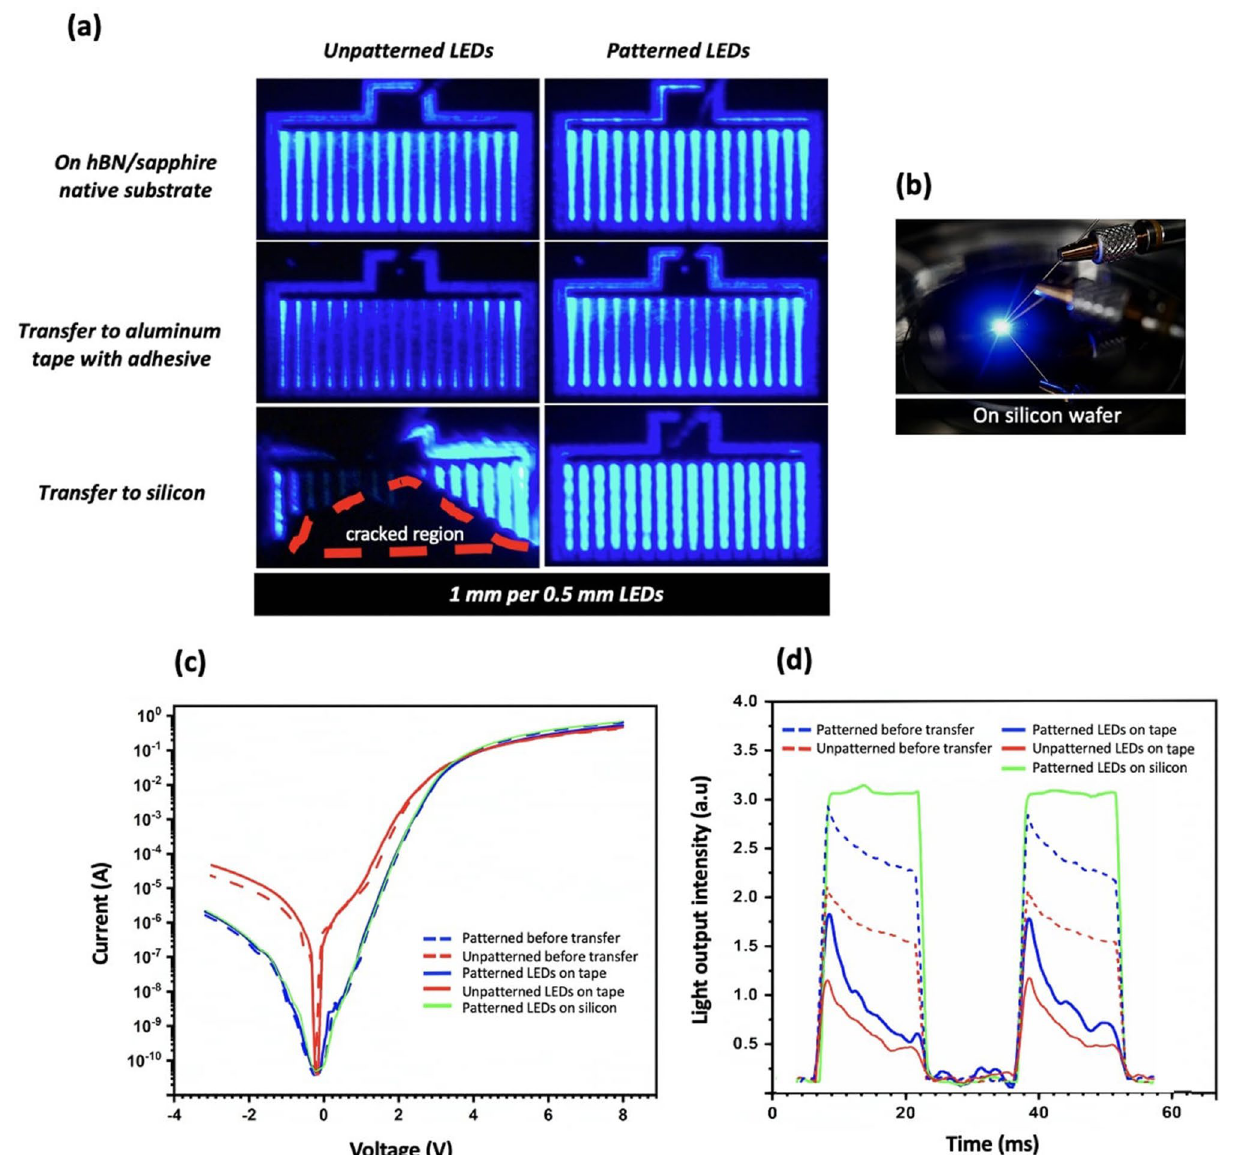
Figure 7. ( a ) EL images of LEDs before and after transfer to different substrates ( b ) Photograph of light emission from an LED on silicon ( c ) I–V characteristics of LEDs before and after transfer to aluminum tape and silicon ( d ) Light output versus operation time of patterned and unpatterned devices before and after transfer to aluminum tape and